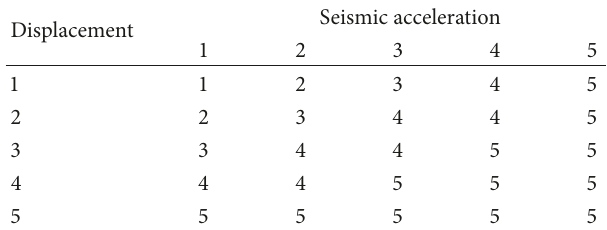
Table 3: Fuzzy control rule table